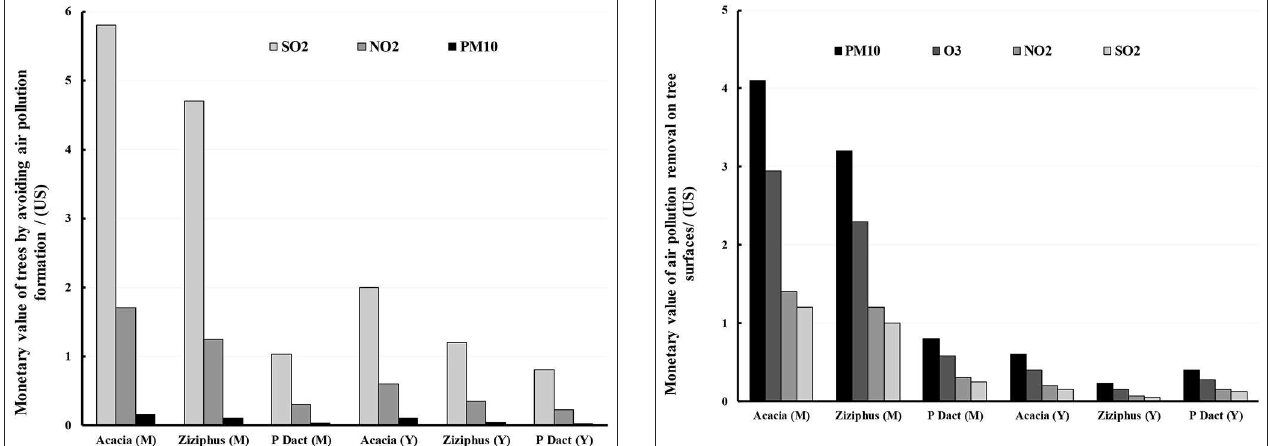
FIGURE 2 | The monetary value of trees by avoiding air pollution formation. “M” indicates mature trees with trunk diameter of 45 in. or greater, “Y” indicates young tress with trunk size of < 10 in, “P Dact” indicates Phoenix Dactylifera .